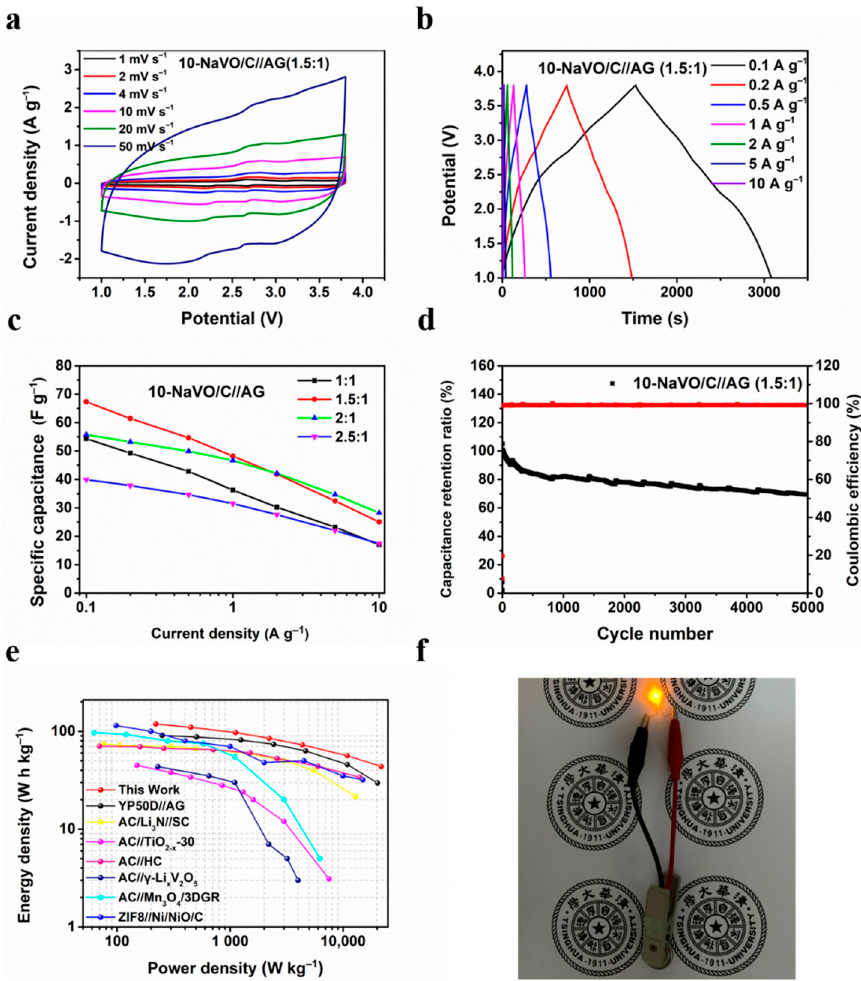
Figure 4. Electrochemical performances of 10-NaVO/C in Li-ion capacitor tests from 1 to 3.8 V. ( a ) CV curves of the 10-NaVO/C//AG (1.5:1) lithium-ion hybrid capacitor (LIC) device at various scan rates; ( b ) charge/discharge potential profiles at different current densities; ( c ) specific capacitance of the LICs with various cathode-to-anode weight ratios; ( d ) cycle behavior of the 10-NaVO/C//AG (1.5:1) device at a current density of 1 A g − 1 ; ( e ) Ragone plots of the 10-NaVO/C//AG (1.5:1) device and other advanced LICs in previous work; ( f ) digital photograph of the lightened yellow